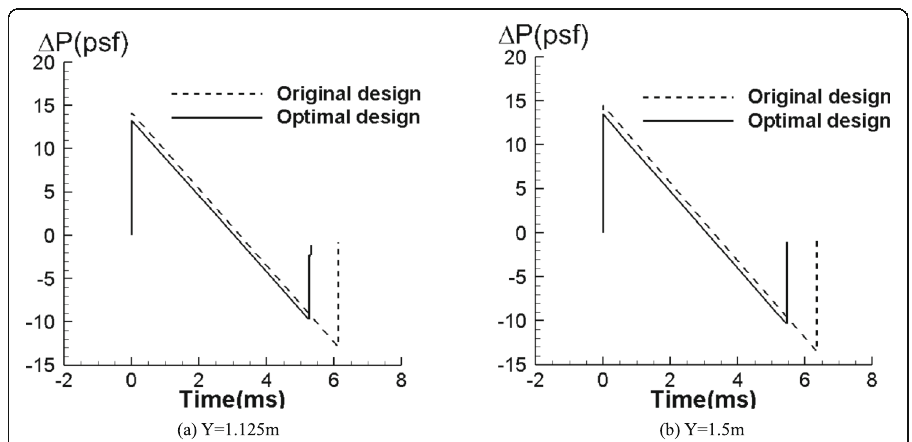
Fig. 25 The ground boom signatures of the baseline wing and the optimized wing from the intersection of surface Z = -2 m and a surface Y = 1.125 m b Y = 1.5